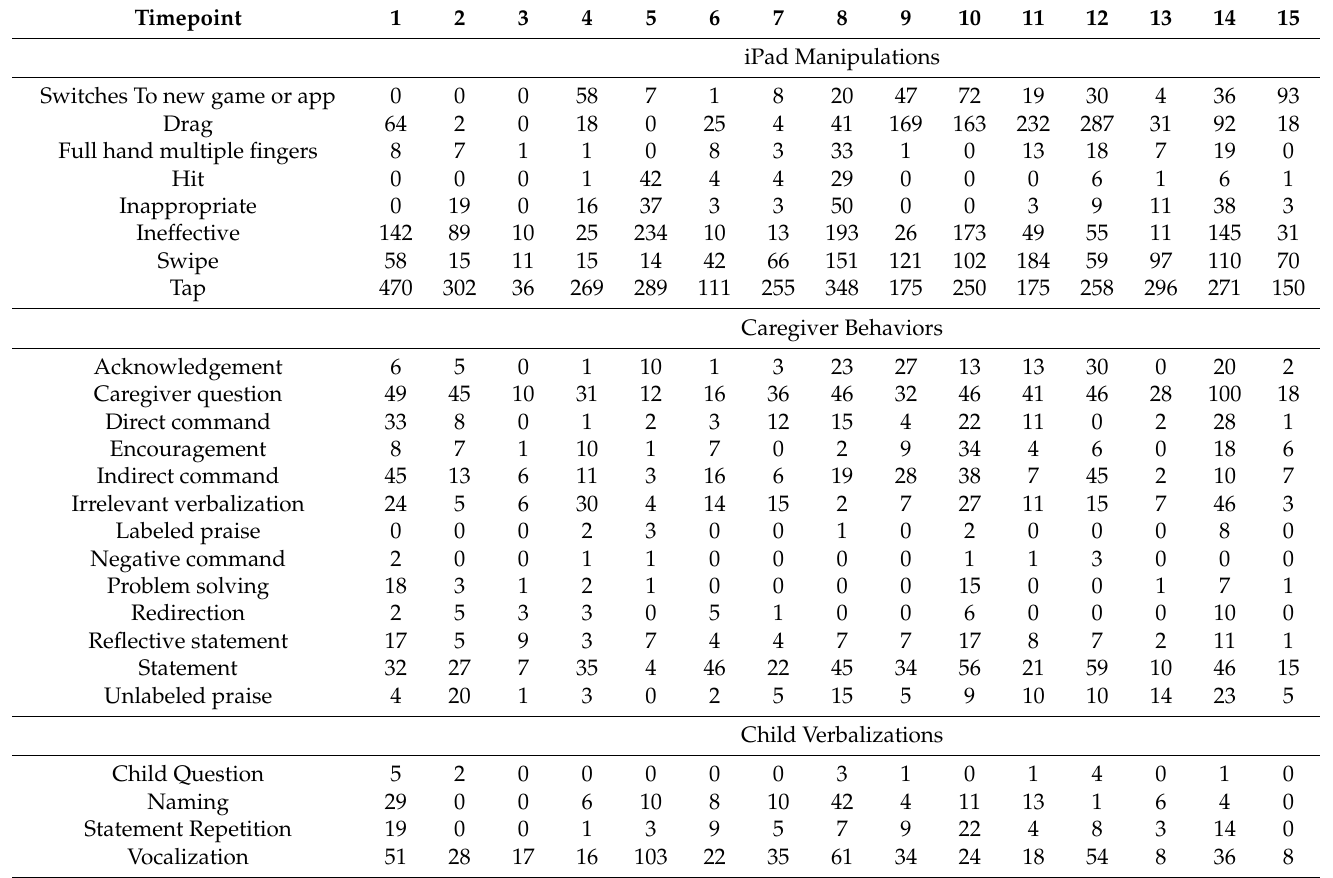
Table 3. Total occurrences of behaviors across all